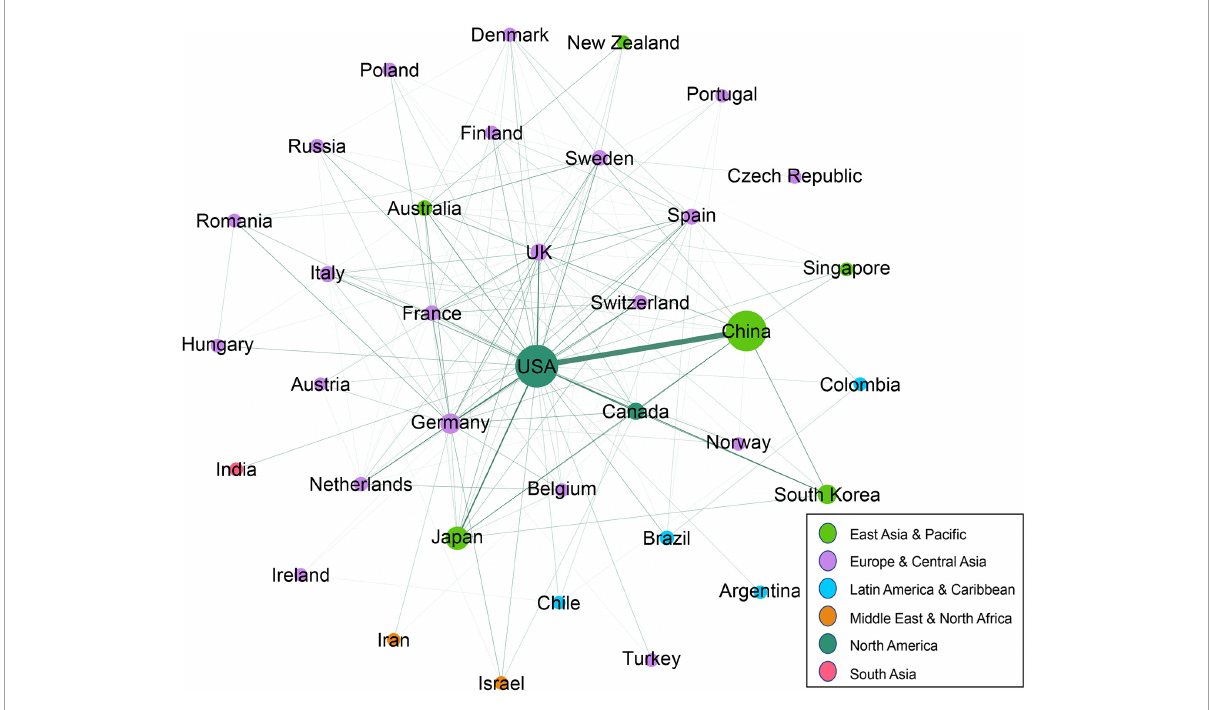
FIGURE3 Collaboration networks of the countries with ten or more